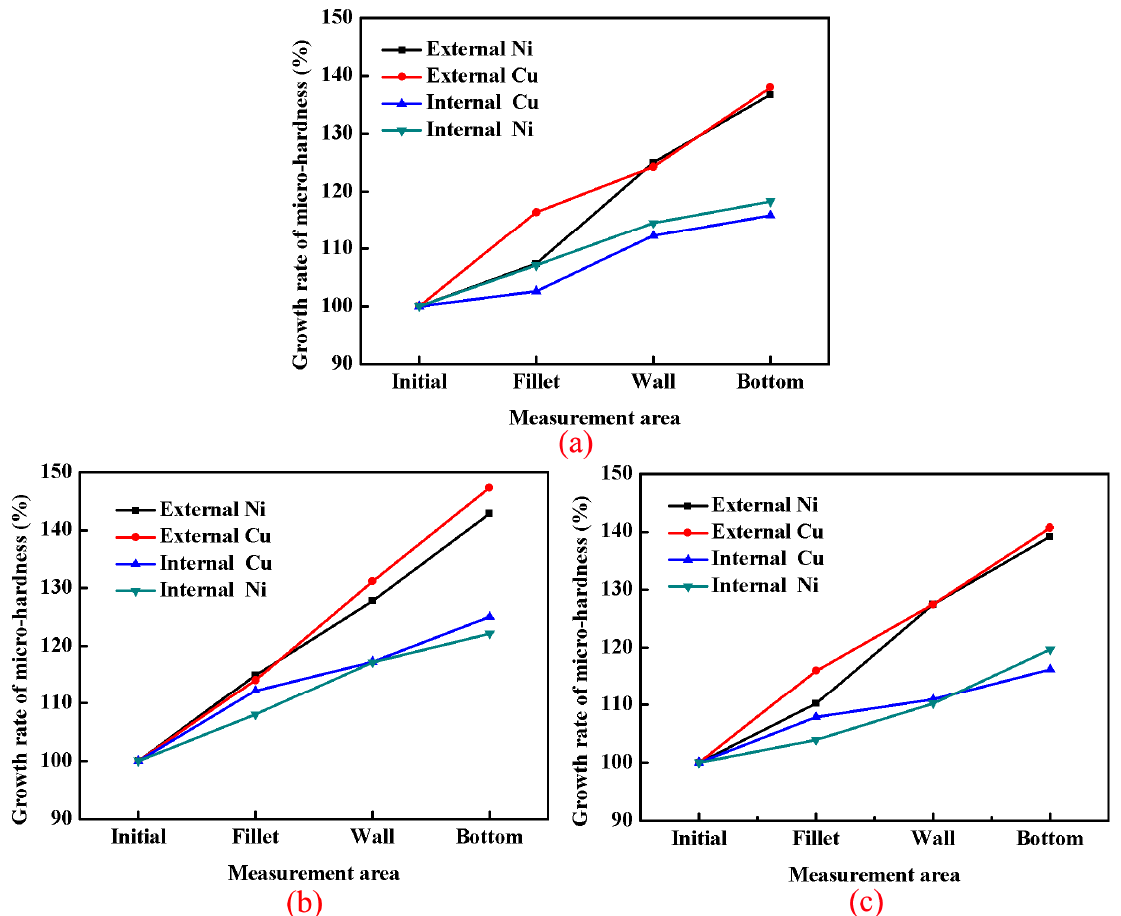
Figure 16. Variation trend of micro-hardness with different feature size: ( a ) mold 1; ( b ) mold 3; ( c ) mold 5.